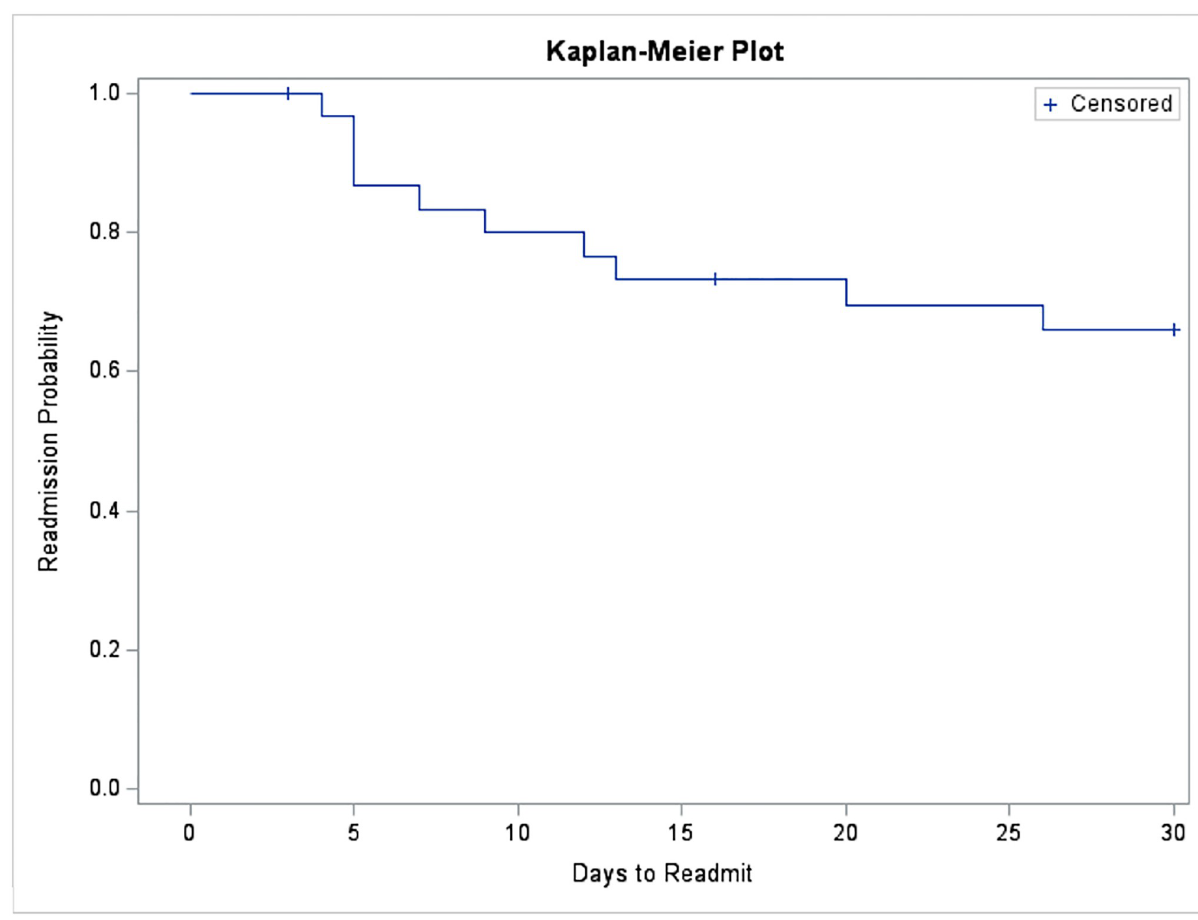
Fig 2. Kaplan Meier plot of readmission